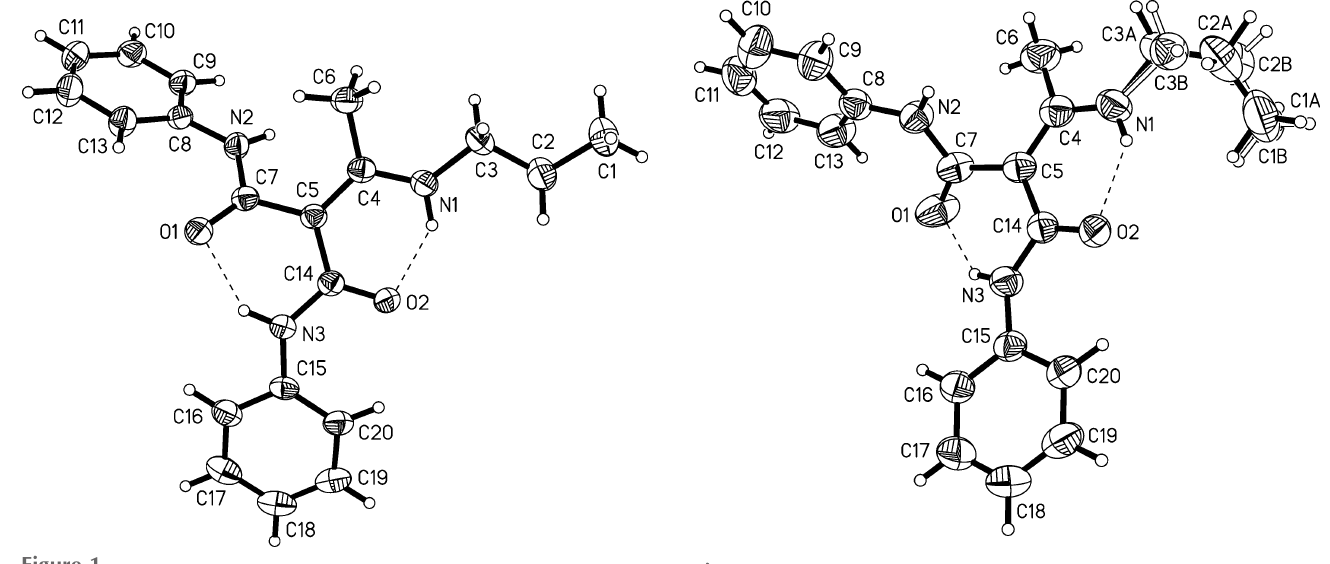
Figure 2 Diagram of polymorph ( II ) showing the atom-labelling scheme. Atomic displacement parameters are at the 50% probability level.